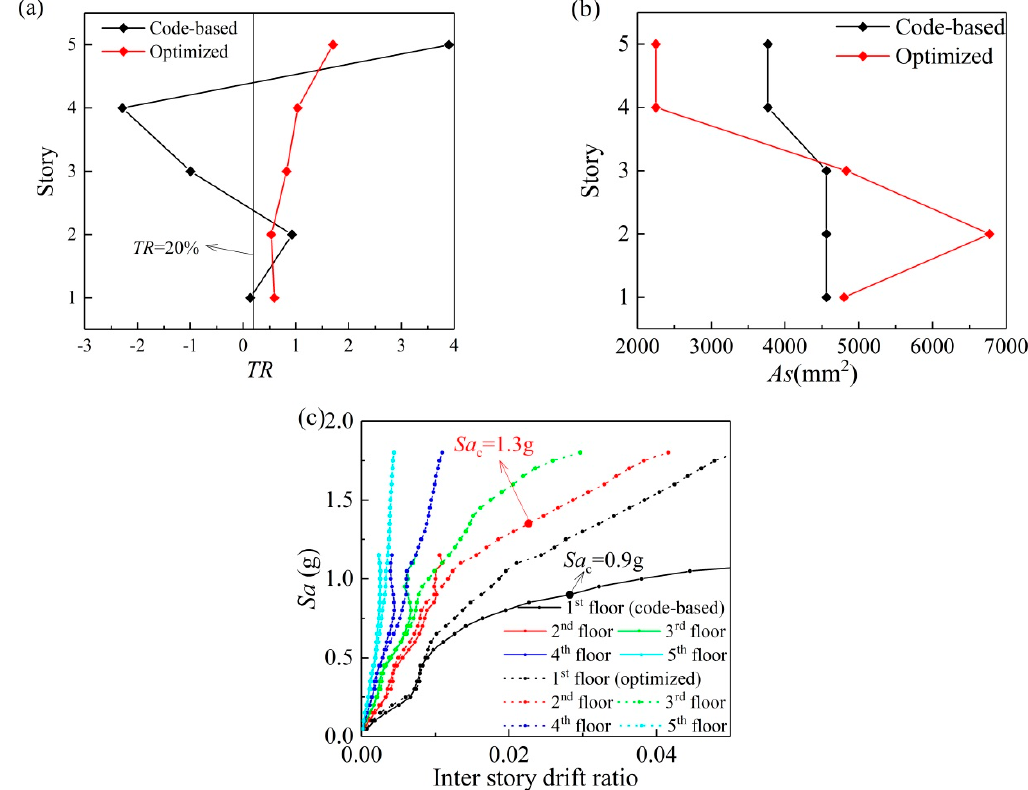
Figure 6. TR , IDA curves, and longitudinal reinforcement comparison of CSDBC-designed structure and optimized structure: ( a ) TR of each floor, ( b ) longitudinal reinforcement of single column for each floor, ( c ) IDA curves for each floor.